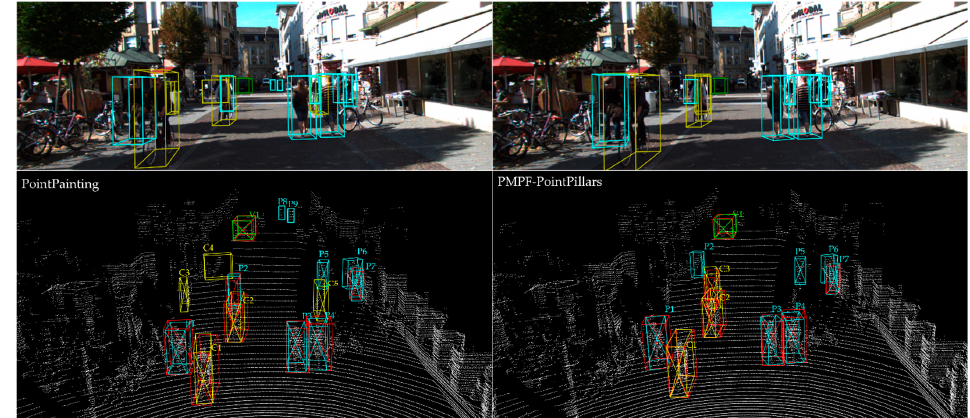
Figure 6. Qualitative comparison between PointPainting [9] ( left ) and PMPF ( right ) on the KITTI validation set. The figures are marked in the same way in Figure 5.